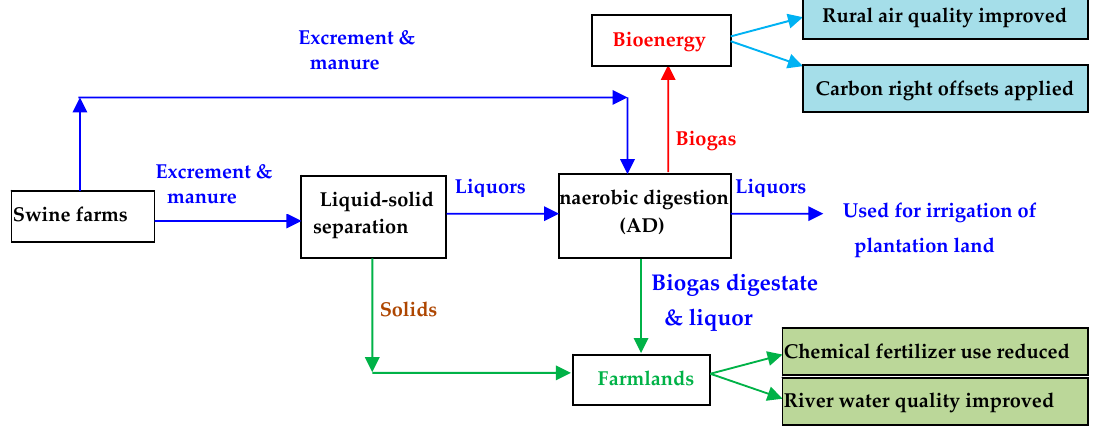
Figure1. Flow-sheetofvalorizingthevalue-addedresourcesfromtheswine-raisingmanuremanagement in Taiwan and its energy and environmental Figure 1. Flow-sheet of valorizing the value-added resources from the swine-raising manure management in Taiwan and its energy and environmental benefits.